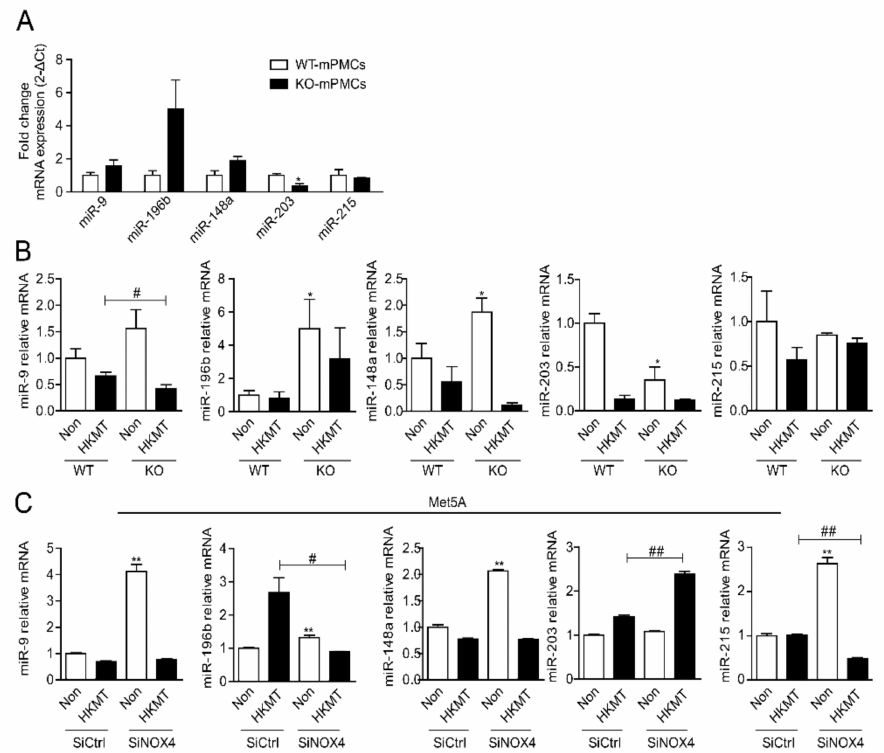
Figure 2. miRNA expression in mesothelial cells with HKMT treatment. ( A ) miRNA expression in mPMCs of WT mouse and NOX4 KO mouse ( n = 3) ( B ) miRNA expression in mPMCs of WT mouse and NOX4 KO mouse following stimulation with and without HKMT. * significant difference ( p < 0.05) compared to control group (WT mPMC Non), # significant difference ( p < 0.05) compared to WT mPMC HKMT group ( C ) miRNA expression in human Met5A cells transfected with SiCtrl or SiNOX4 following stimulation with and without HKMT. ** significant difference ( p < 0.01) compared to (SiCtrl), # significant difference ( p < 0.05) compared to HKMT group (SiCtrl + HKMT), ## significant difference ( p < 0.01) compared to HKMT group (SiCtrl +